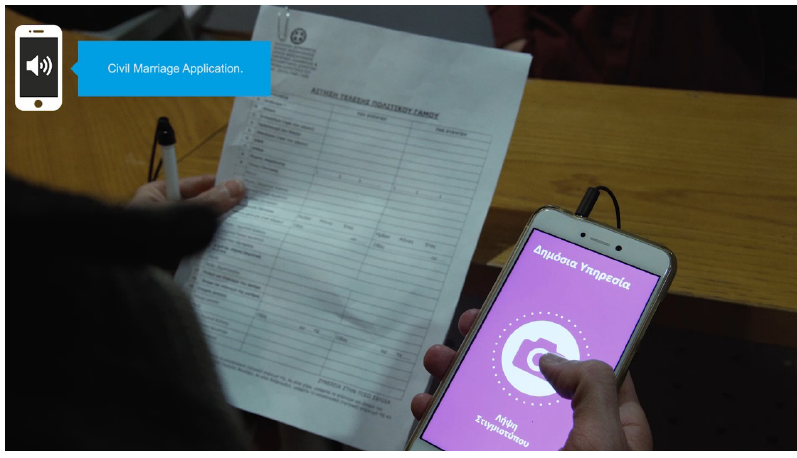
FIG. 9 Usage of the e-Vision application during an actual visit at a public administra- tion by a visually impaired person. The blue textbox contains the message being communicated to the